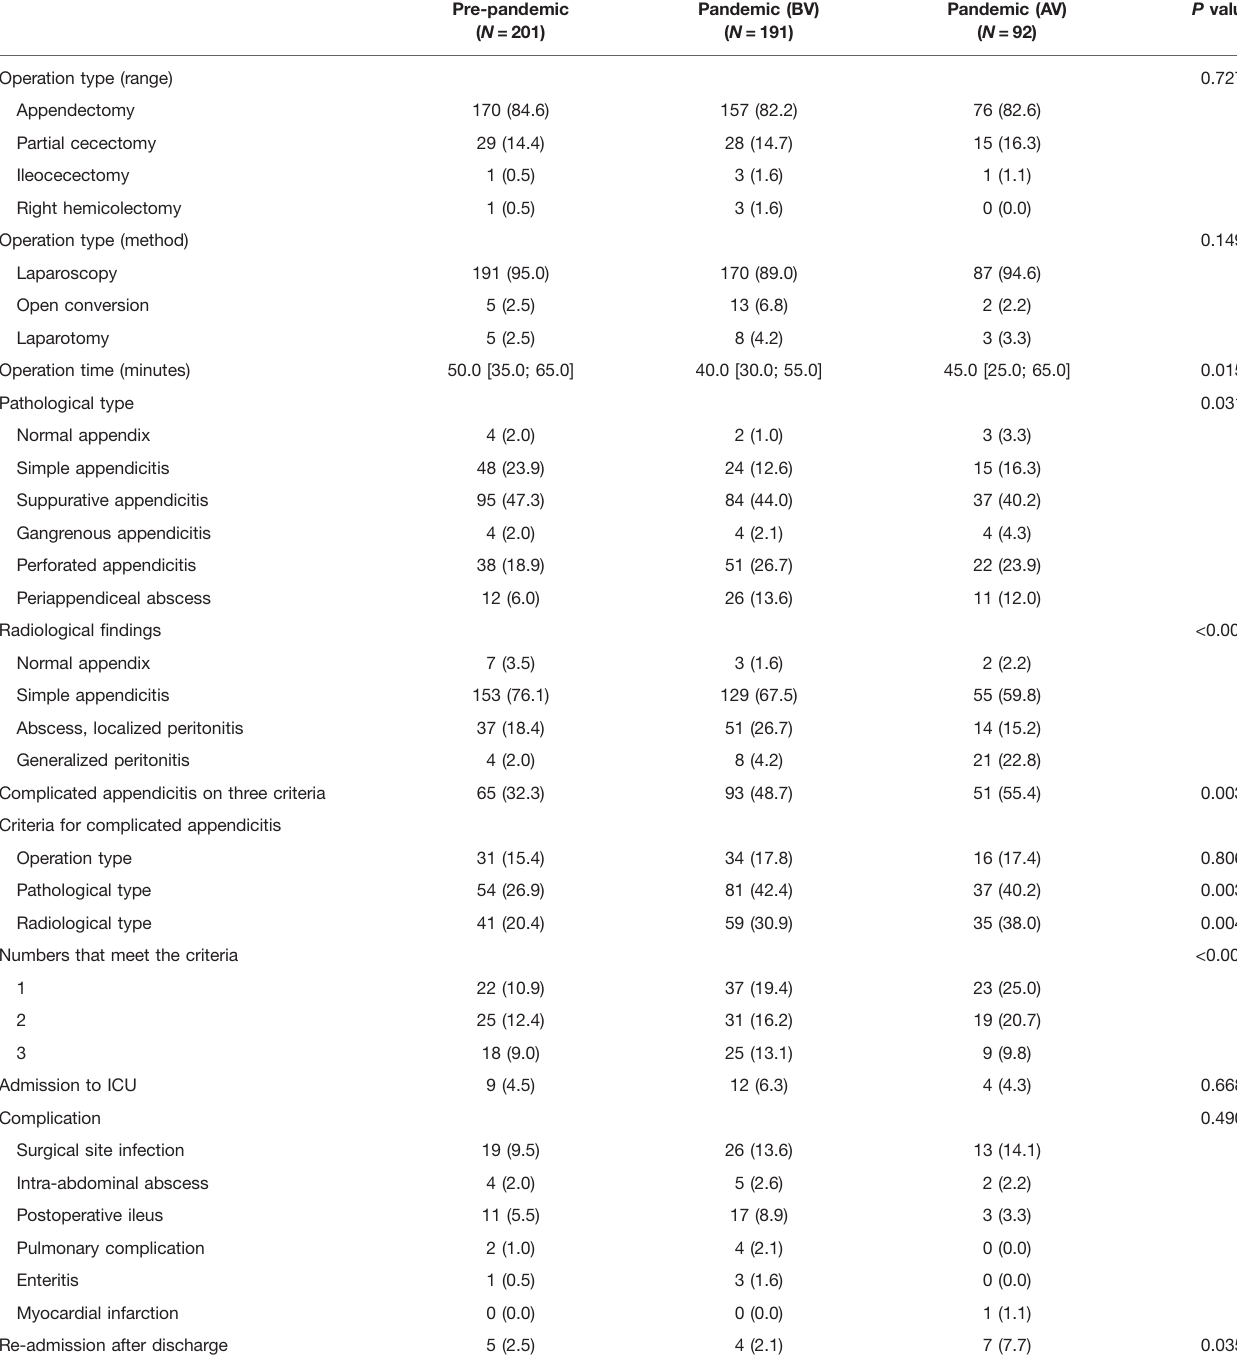
TABLE 3 | Therapeutic characteristics of enrolled